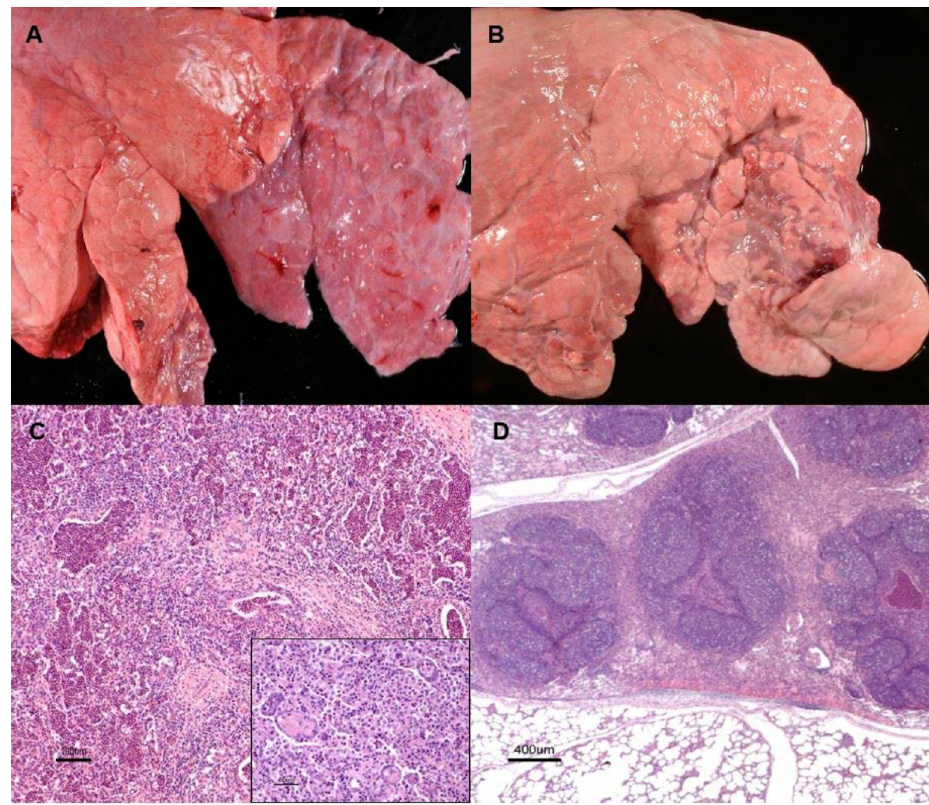
Figure 1. Chronic catarrhal bronchopneumonia. ( A ). Demarcated area of cranioventral lung consolidation with purple tonality, firm consistency and no increase of volume. Mucopurulent content and bronchiectasis were observed (inset). ( B ). Lesion showing recovery features such as coalescing small purple foci, consistent mainly with atelectasis surrounded with lobules with variable degrees of emphysema. ( C ). Haematoxylin-eosin staining (H-E). Histologically, neutrophils and, less in number, macrophages, occupy the bronchioalveolar lumen; foci of newly epithelization (inset) were observed. ( D ). Areas corresponding with atelectasis associated with occlusion of the bronchiolar lumen by inflammatory exudate and the peripheric lymphoid hyperplasia.